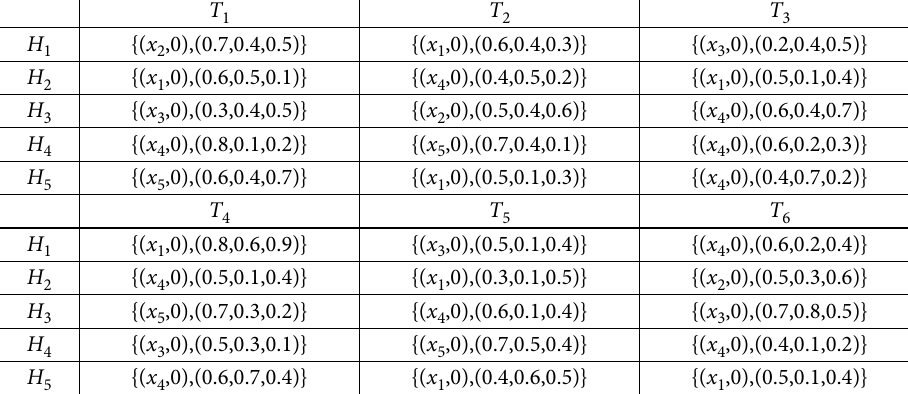
Table 1. Evaluation matri x by W 1